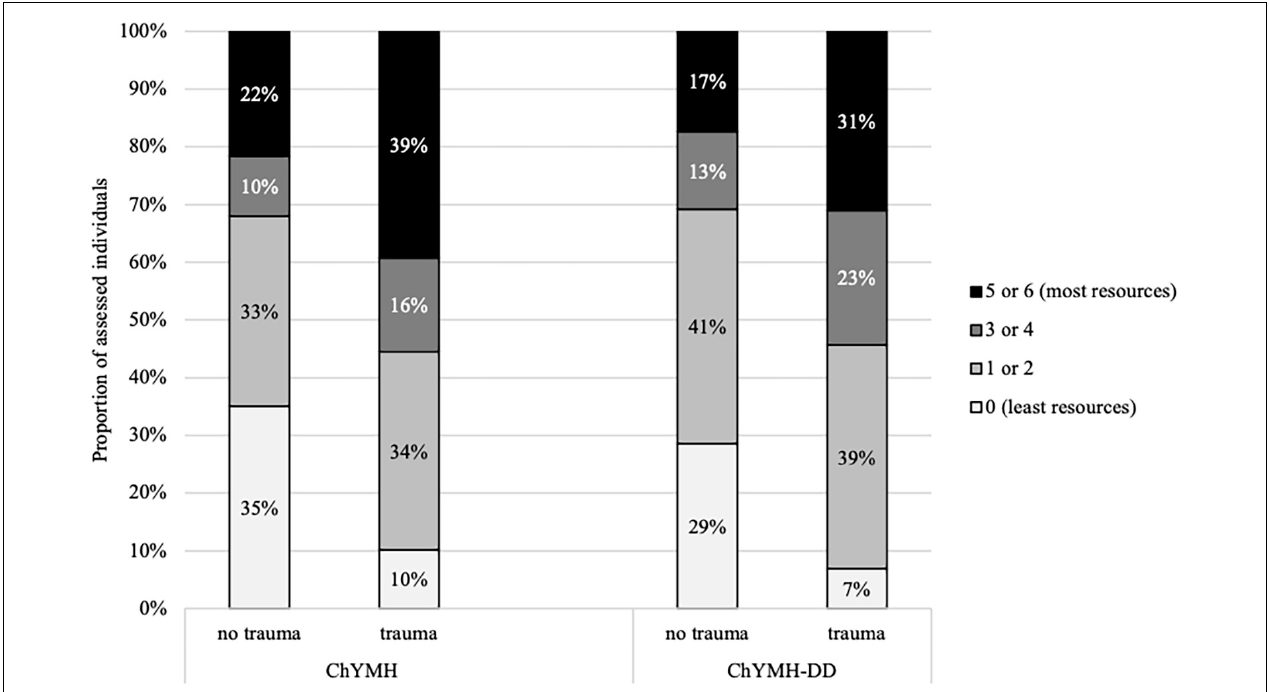
FIGURE 5 | Distribution of the Resource Intensity for Children and Youth (RIChY)